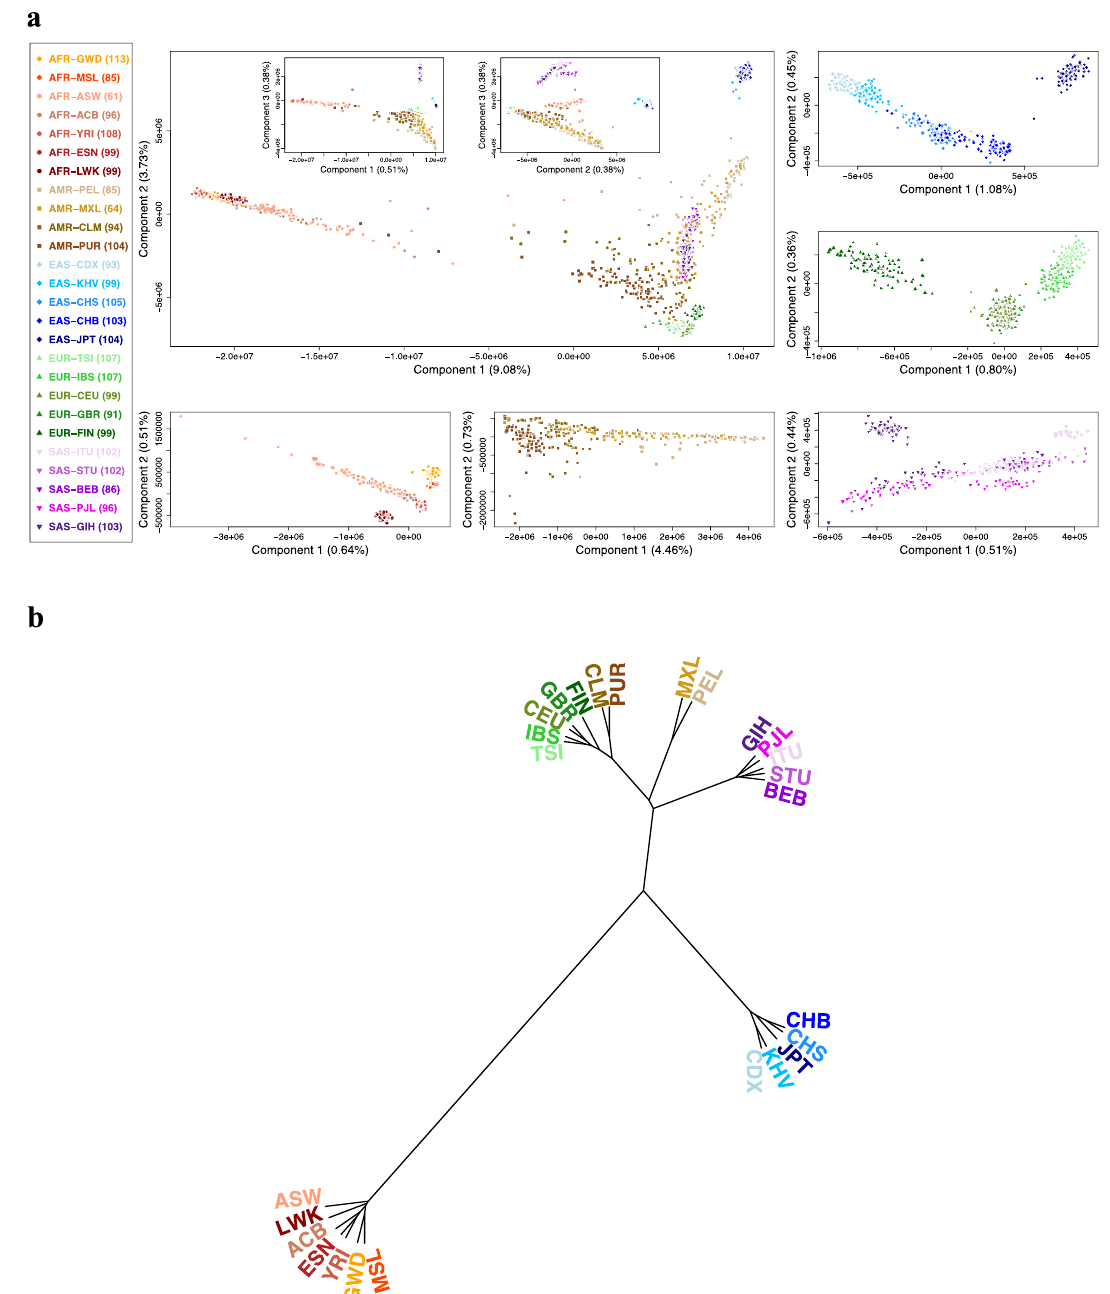
Fig. 4 Global distribution of the whole-genome allele frequency. a Principal component plots of whole-genome allele frequency. b Hierarchical clustering dendrogram of whole-genome allele frequency. Sample size n = 2504